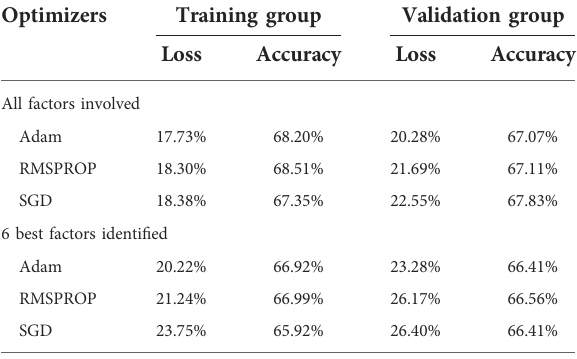
TABLE 4 Model loss and model accuracy estimates of deep learning sequential model in both training group and validation